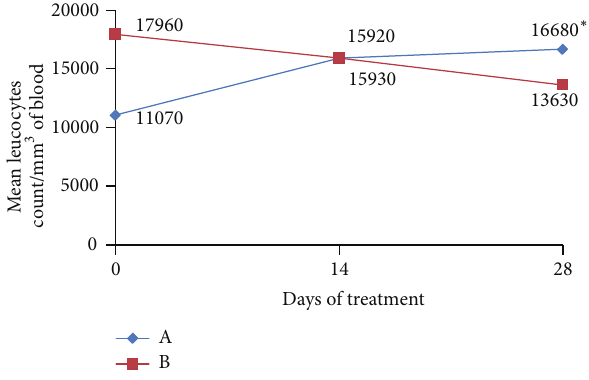
Figure 5: Mean values of leukocytes count in the peripheral blood of animal groups assessed. ∗ significant difference within the group ( 𝑃 < 0.05 ). Reference values: 8000–16000 cells/mm 3 of